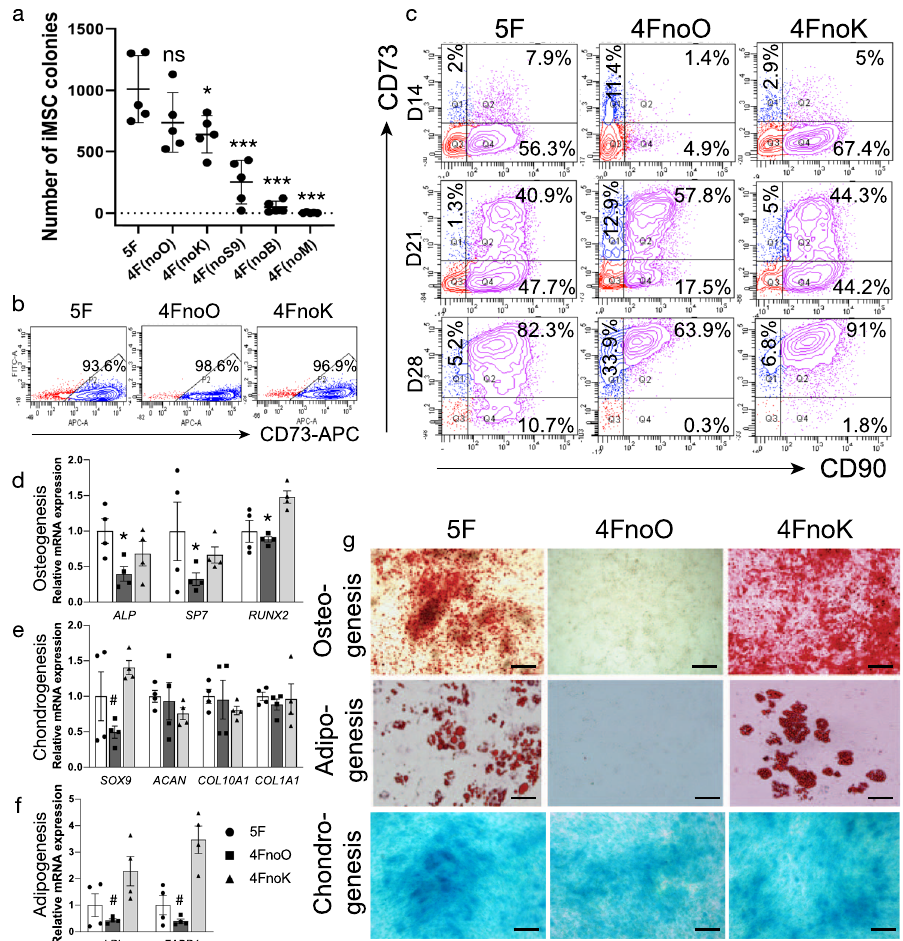
Fig. 3 Impaired trilineage differentiation potential when reprogramming without OCT4. a Reprogramming ef fi ciency with the fi ve-factor combination and removing one of the fi ve factors. One-way ANOVA and Dunnett ’ s multiple comparisons test, * P < 0.05 vs. 5F group, *** P < 0.001 vs. 5F group. ns: not signi fi cant. Error bars indicate standard deviation. n = 5 for each group from biological independent donors. b Flow cytometry analysis of the MSC marker CD73 4 weeks after transfection with 5F, 4FnoO (no OCT4), and 4FnoK (no KLF4). c Flow cytometry analysis of the MSC markers CD73 and CD90 at 2, 3, and 4 weeks after transfection with 5F, 4FnoO (no OCT4), or 4FnoK (no KLF4). d – f RT – qPCR analysis of osteogenesis-, adipogenesis-, and chondrogenesis-related genes in iMSCs reprogrammed with 5F, 4FnoO, and 4FnoK 2 weeks after multilineage differentiation. Tukey ’ s multiple comparisons test, * P < 0.05, 4FnoO vs. 5 F and 4FnoK group. # P < 0.05, 4FnoO vs. 4FnoK group. n = 4 biologically independent samples for each group. Error bars indicate standard deviation (SD). g Multilineage differentiation of iMSCs reprogrammed with 5F, 4FnoO, or 4FnoK. Cells were cultured in osteogenic, adipogenic, or chondrogenic induction medium for 2 – 4 weeks and stained with Alizarin Red (osteogenesis), Oil Red O (adipogenesis), or Alcian blue (chondrogenesis), respectively. Scale bars represent 200 μ